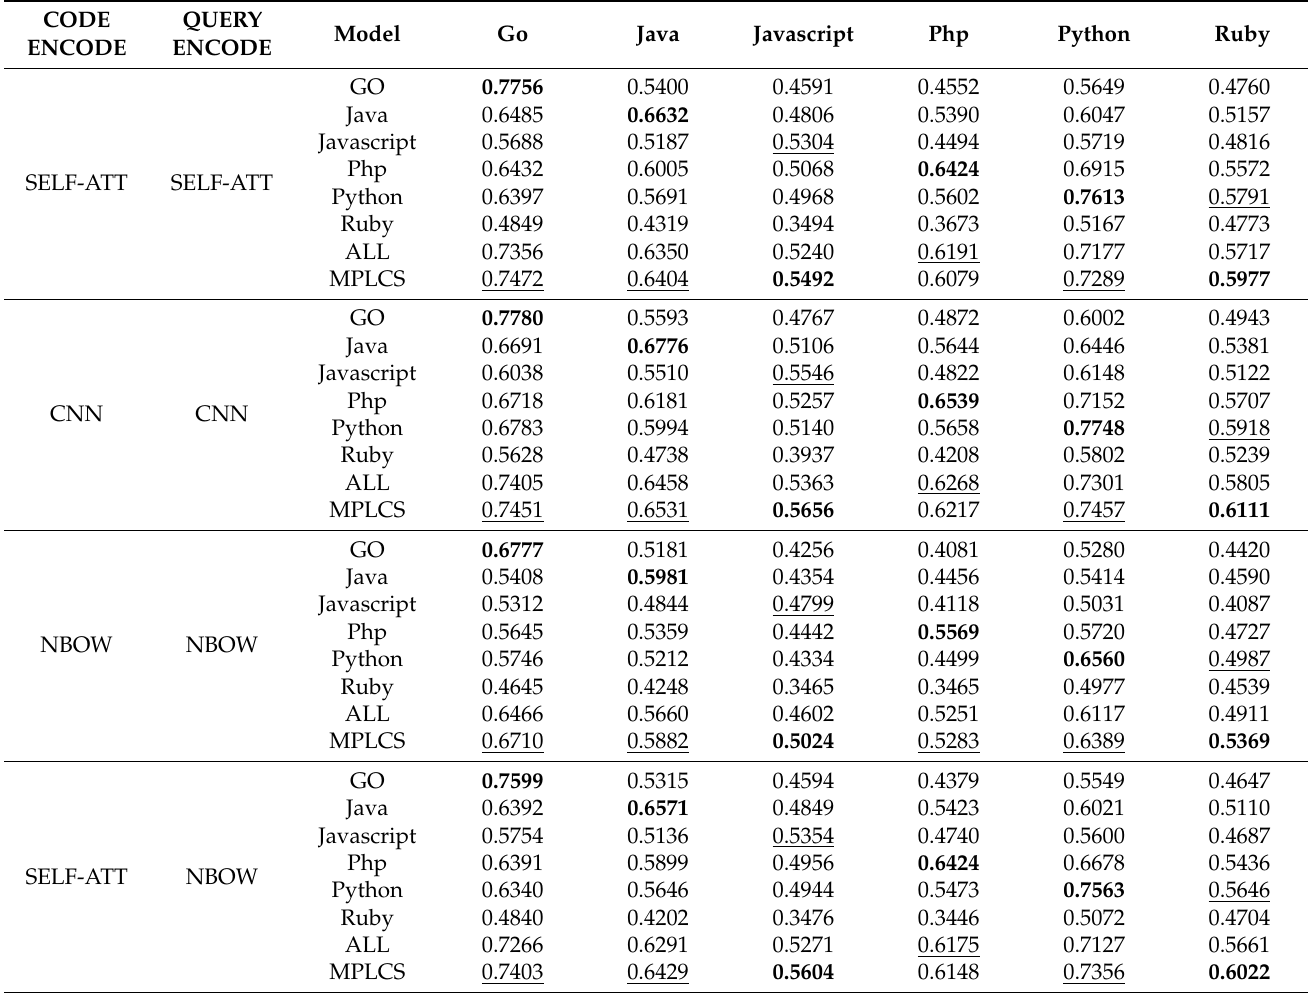
Table 2. MRR for each monolingual model and MPLCS model on different language test sets.